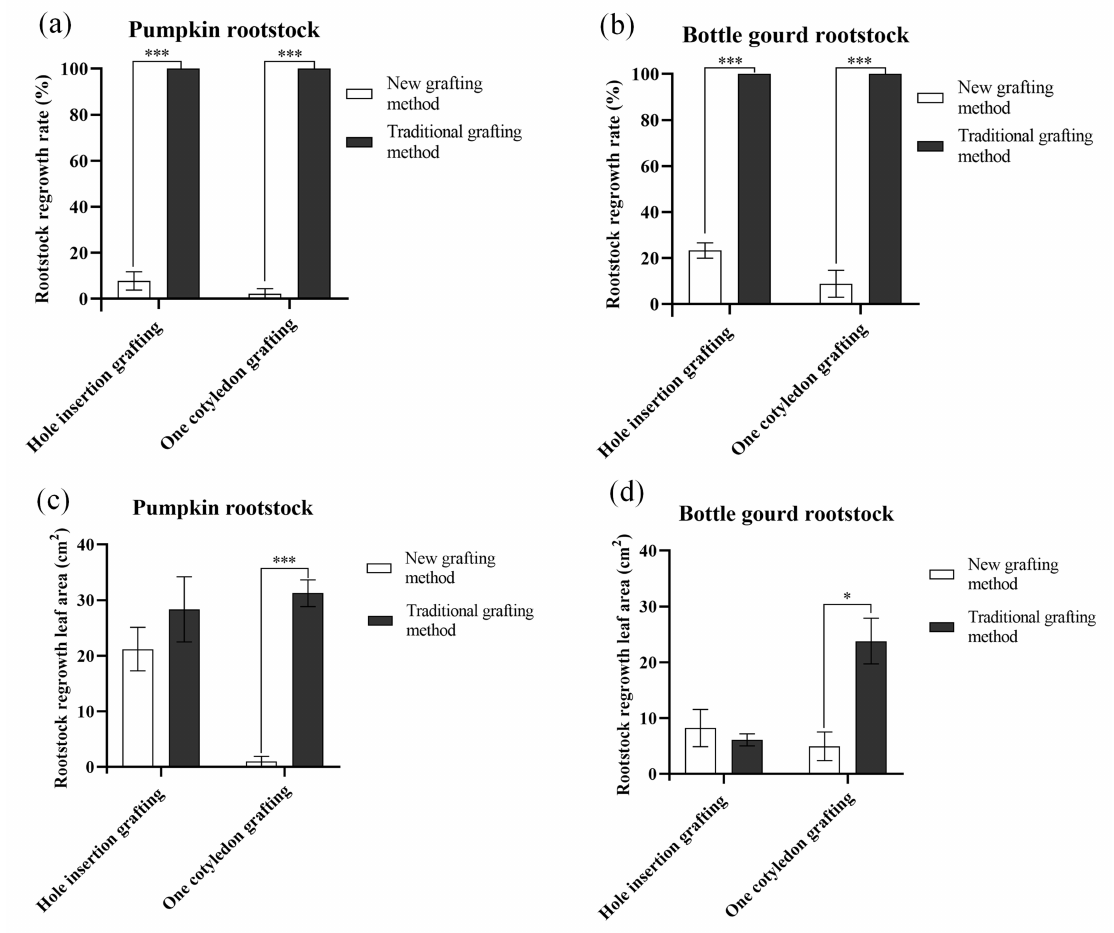
Figure 5. Rootstock regrowth rate ( a , b ) and regrown rootstock leaf area ( c , d ) at day 14 after grafting ( n = 3). The rootstock regrowth was not removed for the new or the traditional grafting methods. For the measurement of regrown rootstock leaf area, only the regrown rootstock plants were investigated and calculated. * and *** indicate significant differences at p < 0.05 and 0.001 levels, respectively.